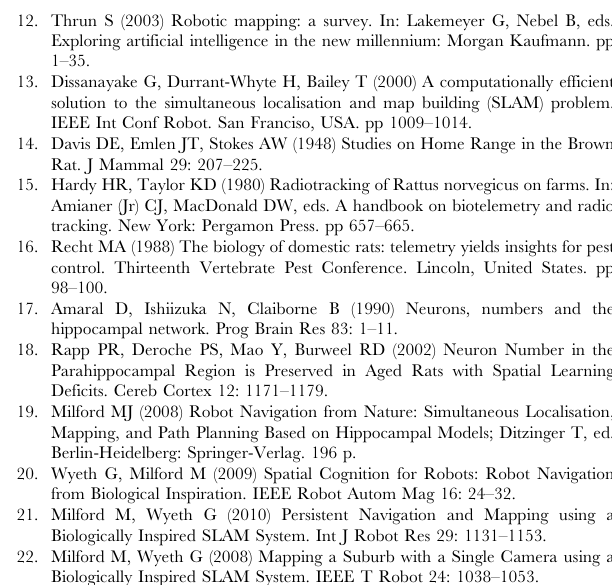
Figure S1 Schematic of the place field binning and corridor zones used in the occupancy likelihood equation. The lightly shaded rectangles show the areas used to calculate the corridor occupancy likelihood, and the dashed grid shows the place field bins, each 0.25 meters square. Figure S2 The sensitivity of a cell network’s path integration process to motion cues affects field size and spacing. (a) Movement trajectories. (b) Firing fields. (c) Average field sizes (d) Field